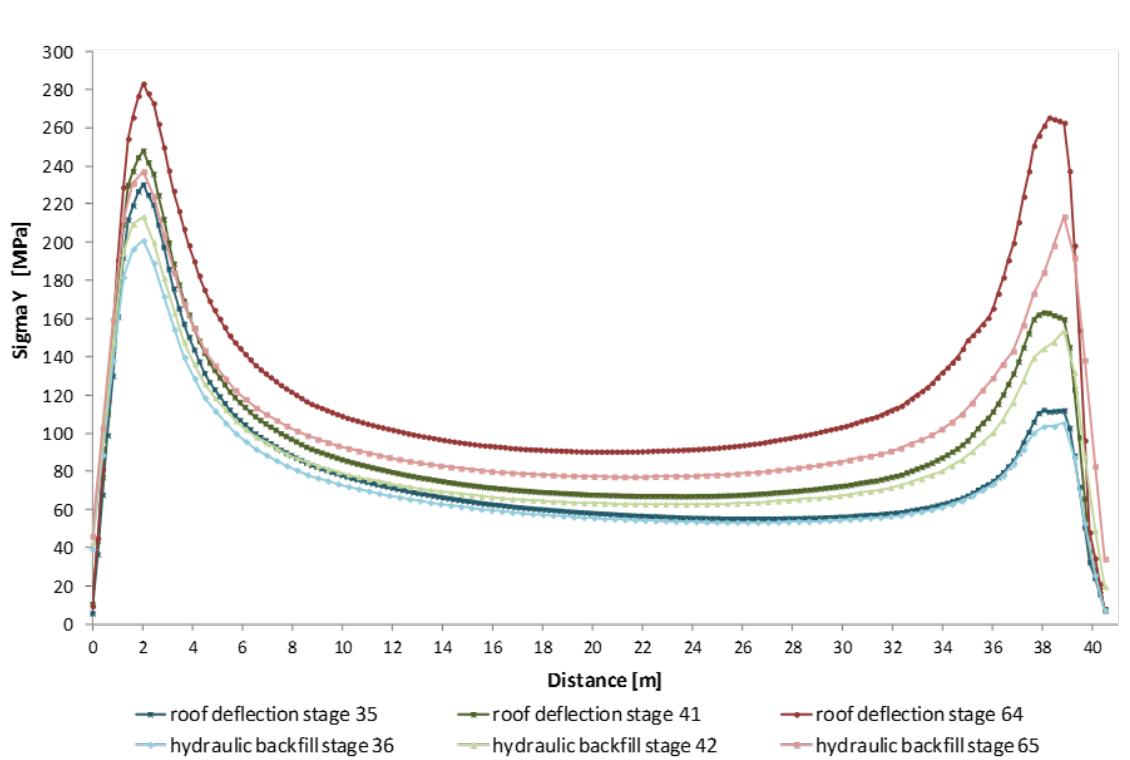
Figure 14. Comparison between vertical stresses σ y in the roof layer 10 m above the remnant for the roof deflection case and the hydraulic backfill case, for the front distance of approximately: 60 m from the remnant edge — computational steps 35, 36, 146 m from the remnant edge — computational steps 41, 42), 470 m from remnant edge — computational steps 64, 65.